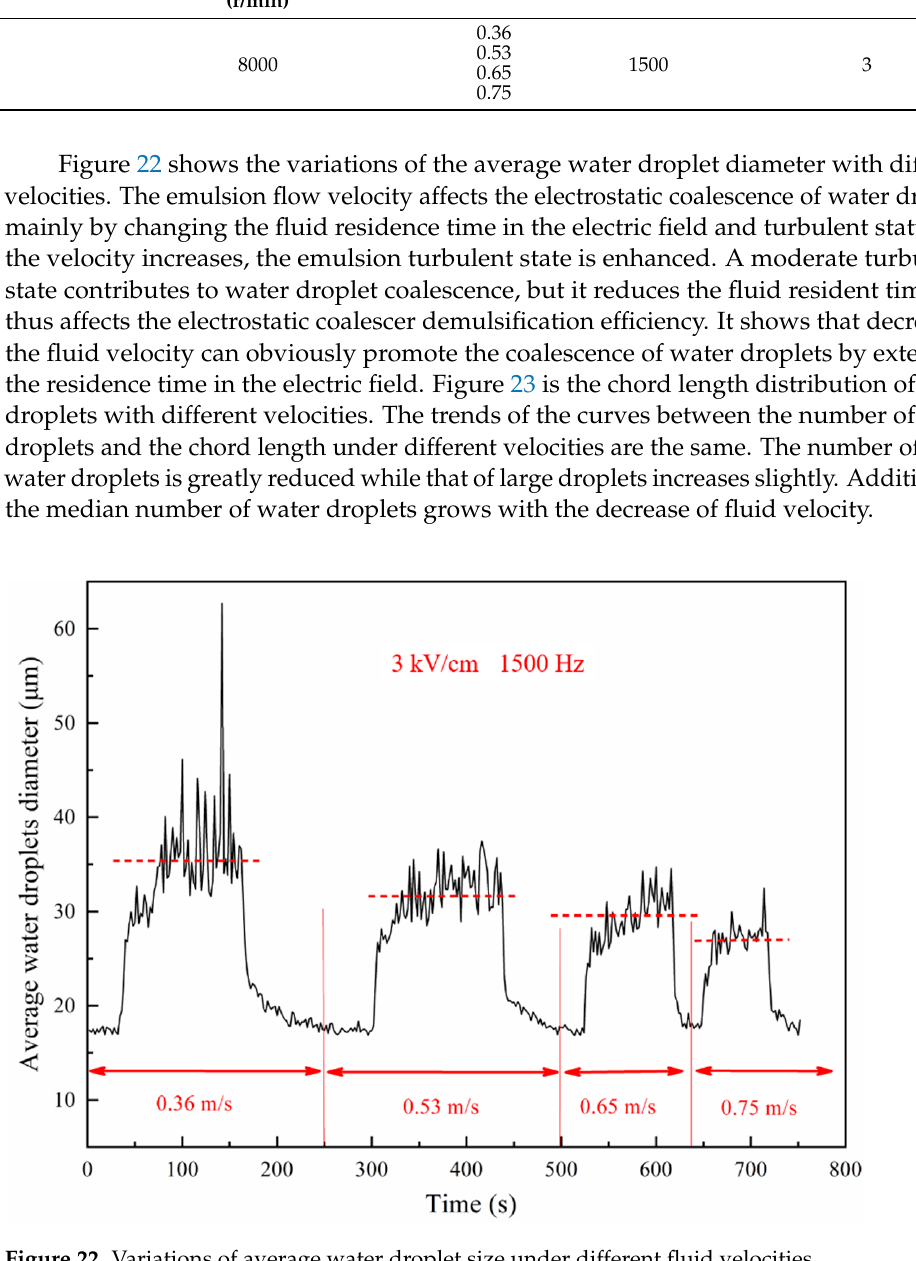
Figure 23. Variations of water droplet number under different chord lengths. 4.6. Comparison of Performance between the Helical Electrode and Parallel-Plate Electrode The comparison of the demulsification performance between the compact electro- static coalescer with a helical electrode and parallel plate electrode are experimentally studied. Figure 24 shows the variation of the average water droplet size with the electric field action time under different electric field strengths. The electric frequency is 50 Hz all the time. Although the maximum electric field strengths with the parallel plate electrode (2.0 kV/cm) is higher than that with the helical electrode (1.8 kV/cm from Figure 12), there is almost no change for the average water droplet size under the action of the electric field if the electric field strength is less than 1.6 kV/cm with the parallel-plate electrode. When the electric field strength is higher than 1.6 kV/cm, the average water droplet size tends to increase when the power is on. As the electric field strength increases to 1.8 kV/cm, the average water droplet size is increased by 58% compared to the initial value with the hel- ical electrode, while that with parallel plate electrode is increased by 24%. There are obvi- ous differences between these two different electrodes. The comparison results once again confirm that the demulsification performance of compact electrostatic coalescer can be significantly enhanced by using the helical electrode.